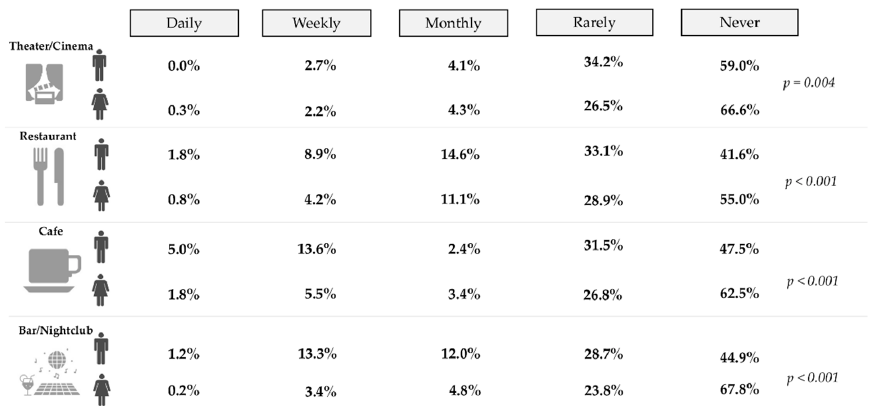
Figure 2. Frequency of the recreational activities by gender ( p, p -value ).